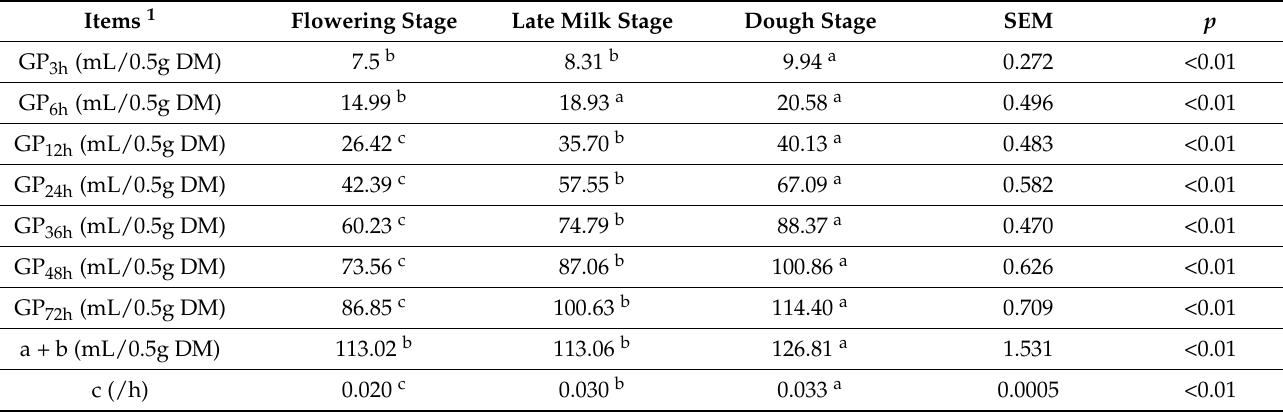
Table 2. Gas production and gas production kinetics of whole wheat hay harvested during three different maturity